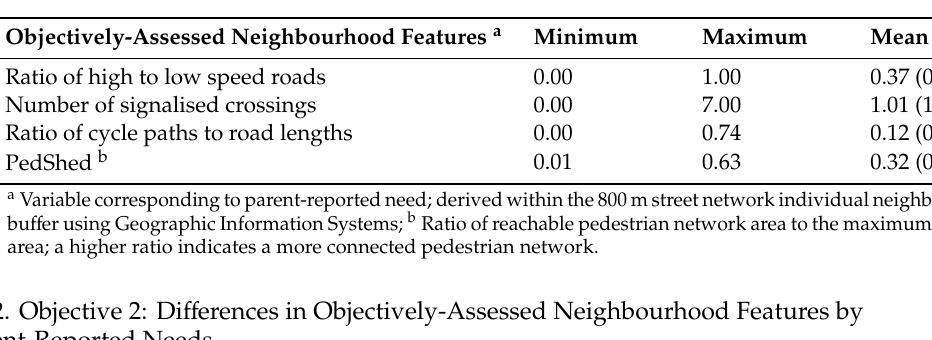
Table 4. Descriptive information for objectively-assessed neighbourhood features ( n =